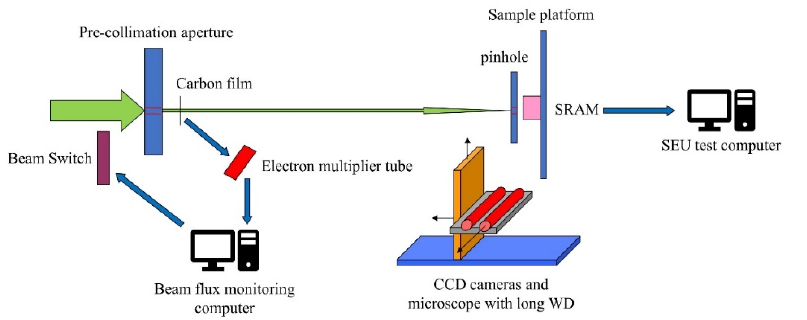
Figure 1. Schematic of the SEU experimental setup (The green arrow represents the ion beam direction).